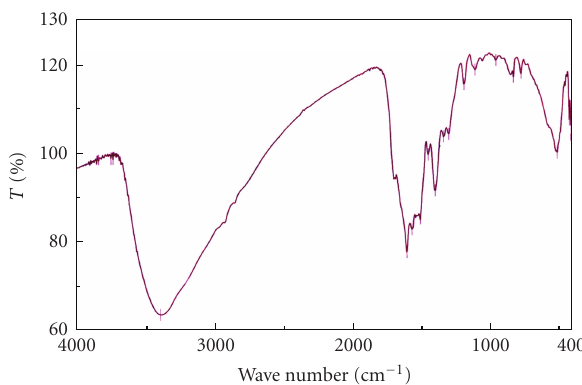
Figure 3: I.R. Spectrum of iron folate complex.